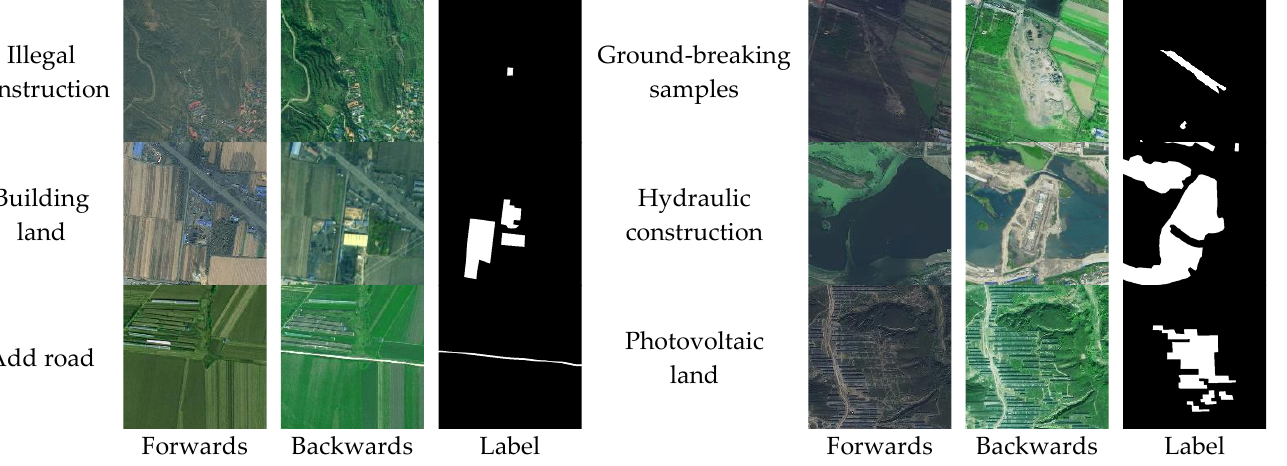
Figure 3. Newly added construction land labeling results.